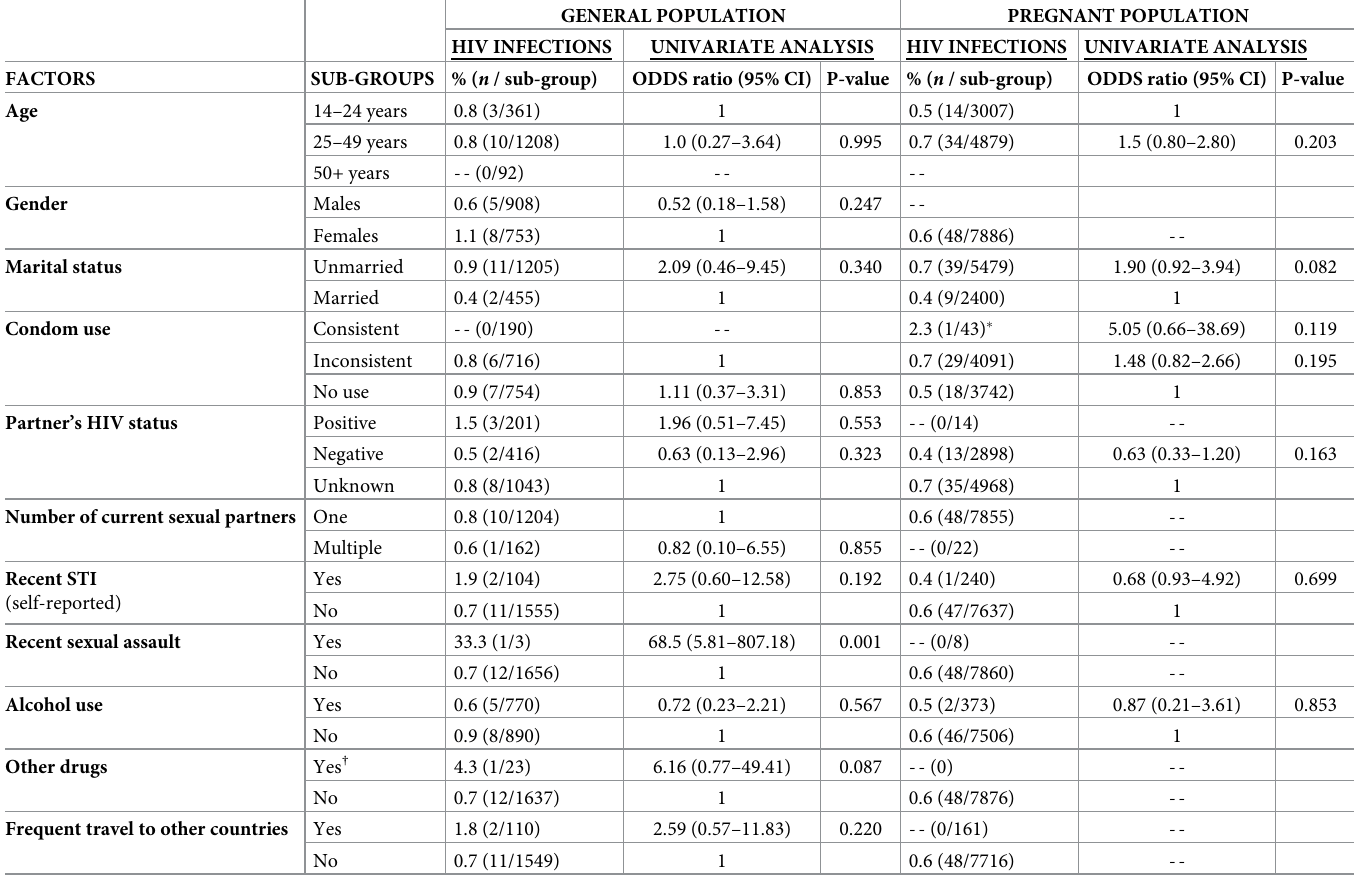
Table 2. Univariate analysis of factors associated with HIV